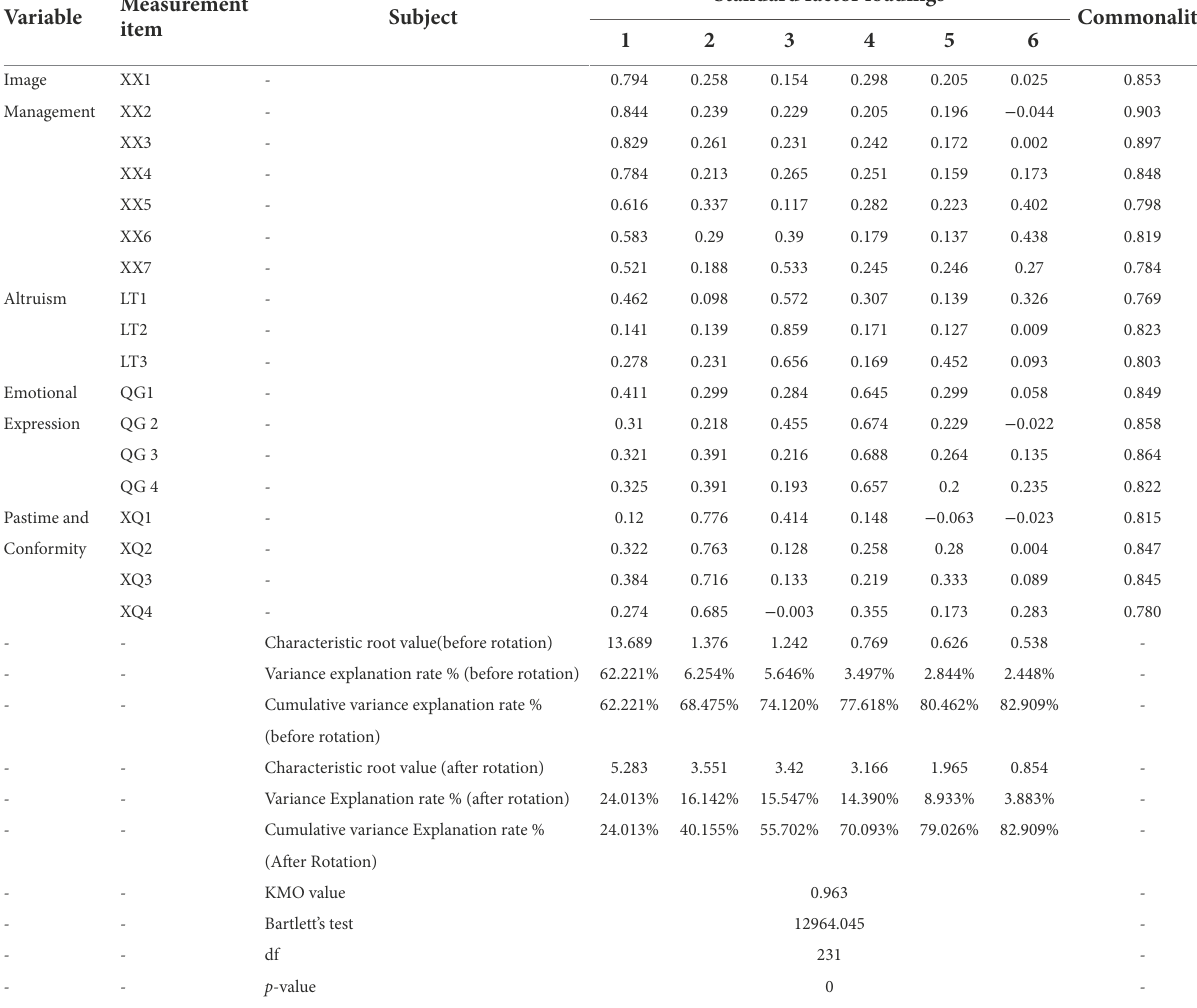
TABLE 6 Validity analysis indicators and results of sharing motivation